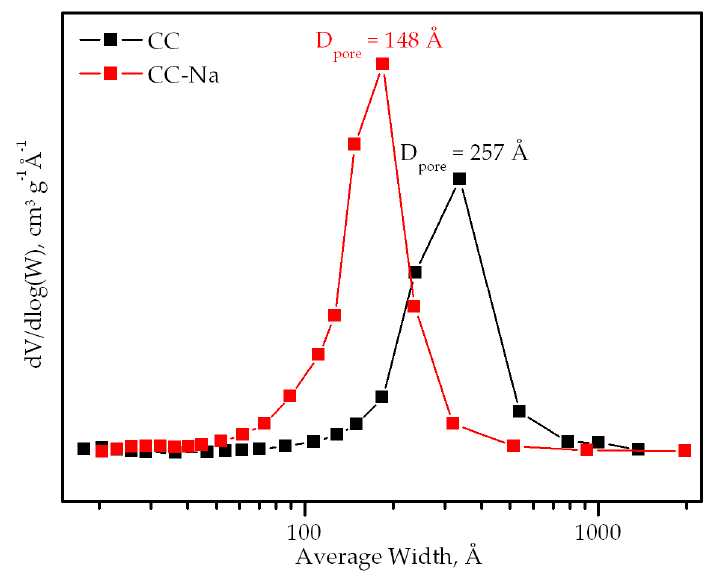
Figure 3. Pore size distributions of the catalysts.